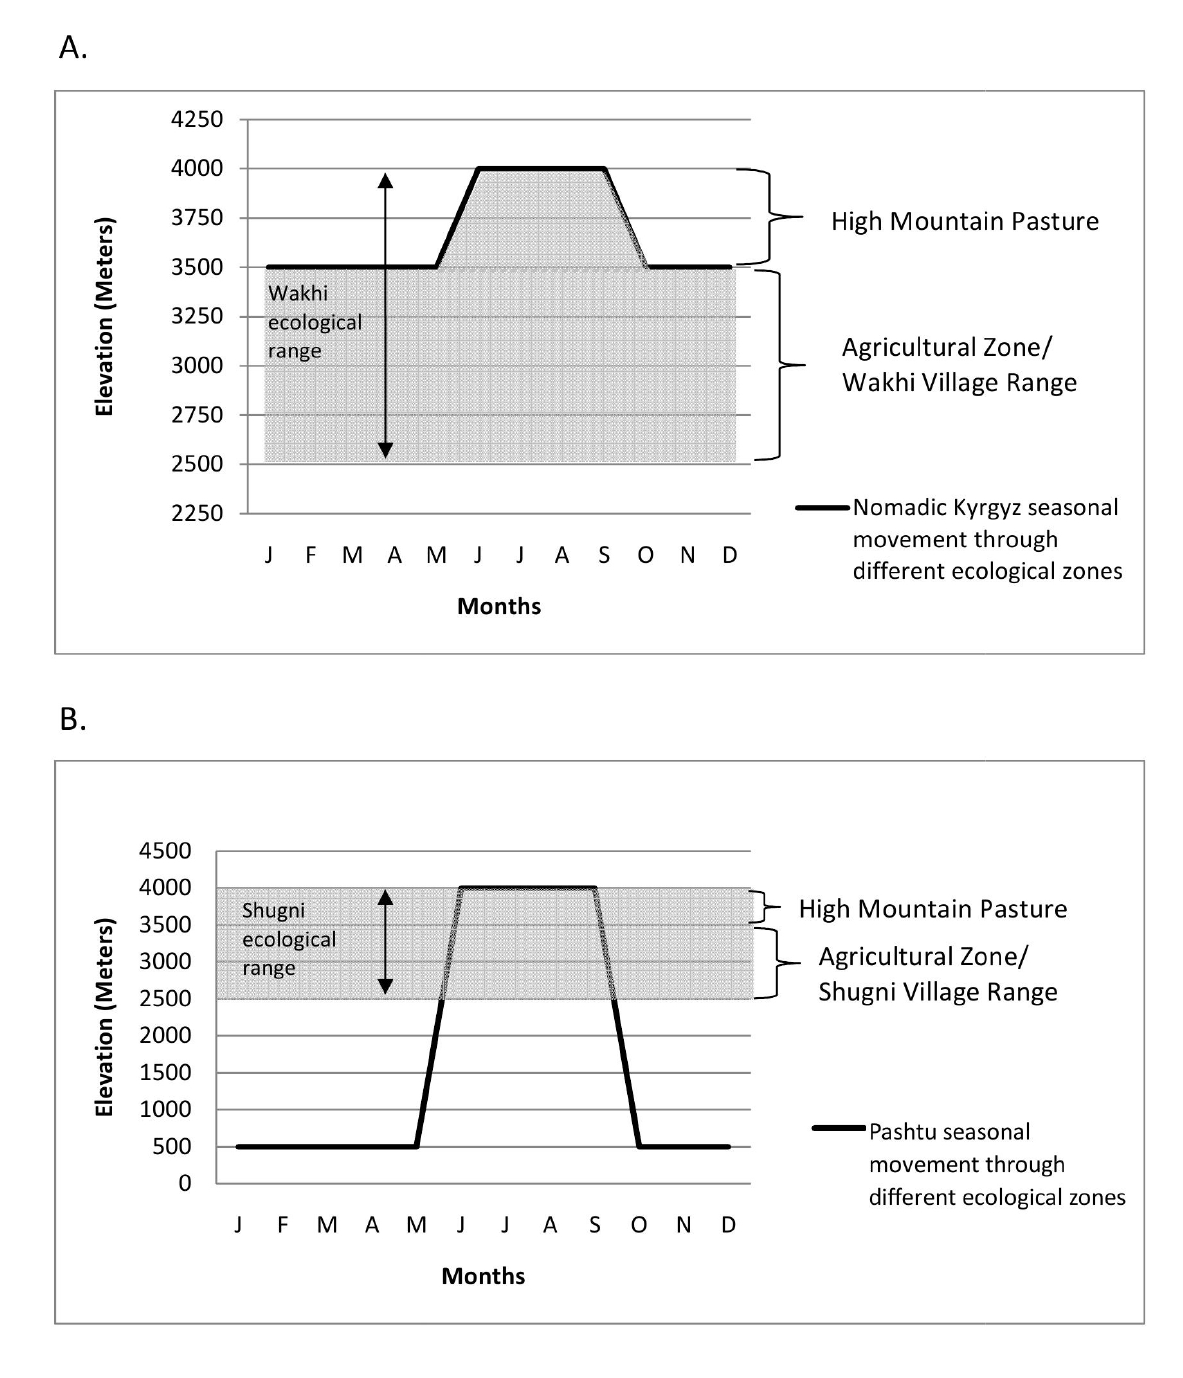
Fig. 6 . Seasonal overlap of ecological niches of (A) the Kyrgyz and Wakhi and (B) the Pashtu and